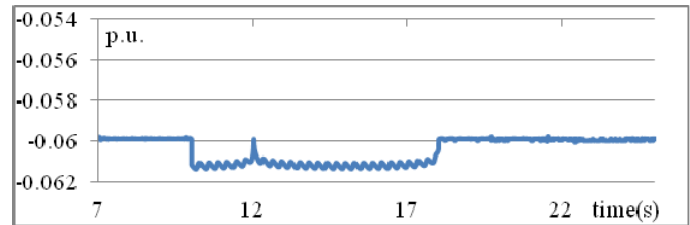
Figure 12. Variations of MW generations from PV (Scenario